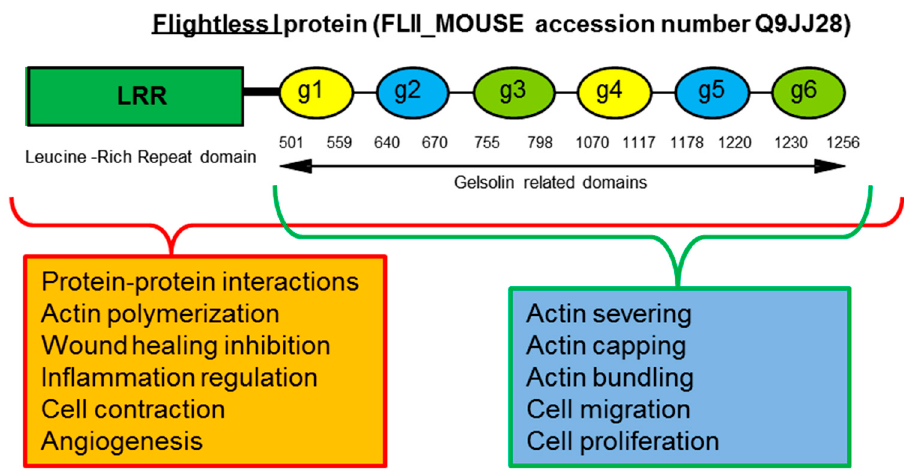
Figure 2. Schematic diagram of Flightless protein structure. Flightless protein consists of Gelsolin segmental repeats (g1–g6) in Gelolin related domain and unique Leucine Rich Repeat Domain (LRR). Each domain has associated cellular functions.